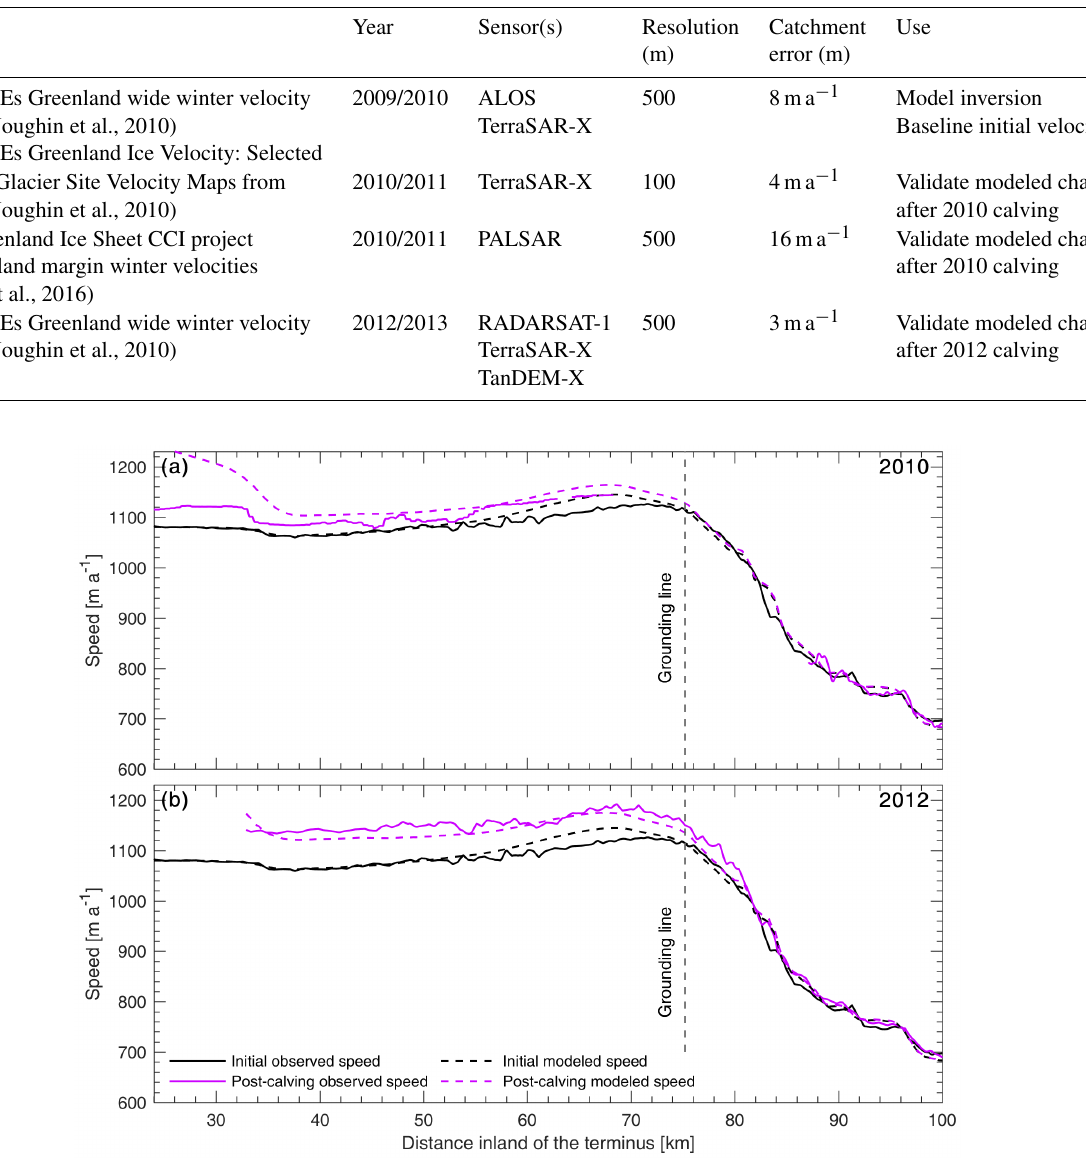
Figure 2. Observed and modeled velocities along the Petermann Glacier centerline before and after calving events in 2010 (a) and 2012 (b) . Observed initial speed (MEaSUREs InSAR winter 2009/2010) is shown with a solid black line. Observed post-calving speeds after the 2010 calving event (PALSAR and TerraSAR-X winter 2010/2011) and the 2012 calving event (MEaSUREs InSAR winter 2012/2013) are shown with solid purple lines. Modeled initial speeds are shown in dashed black, and speeds after each respective modeled calving event are shown in dashed purple. Note the small change in both observed and modeled velocities, particularly inland of the grounding